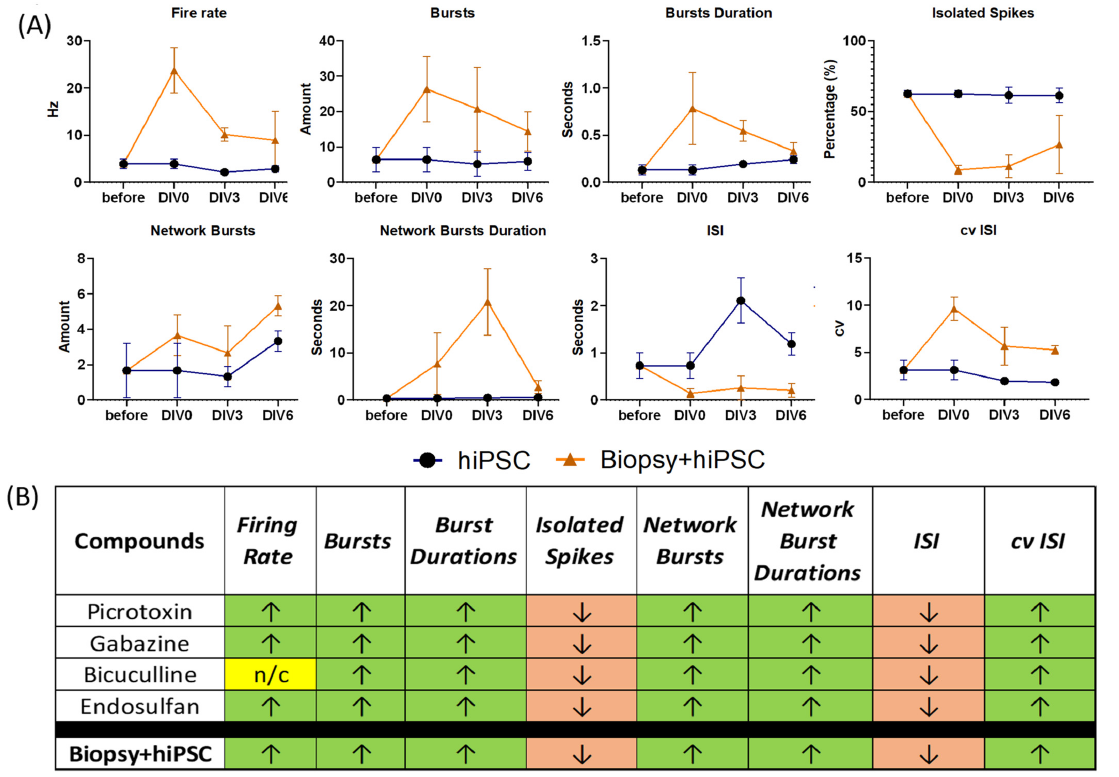
Figure 5. Electrophysiological characterization. ( A ) Fire rate, bursts and burst durations, isolated spikes, network bursts and durations, as well as ISI and cv of ISI of the hybrid model (hiPSC + Biopsy, orange), with hiPSC neuronal derived cultures (DIV16 = DIVO on graph) measured before and after biopsy assembly for 6 days and compared with the control hiPSC neuronal-derived cul- tures (DIV16) (hiPSC, blue) during the same 6-day period. Error bars represent mean with SEM of three 2 min recordings per condition. ( B ) The hybrid model displayed a higher firing rate, number of bursts, longer burst durations, network burst and durations, and a higher CV of ISI than the biopsy or neuronal monolayer alone. The hybrid model was also characterized by a decreased per- centage of isolated spikes and a reduced inter-spike interval. Taken together, the electrophysiolog- ical output signature of the hybrid model corresponds to the seizurogenic profile of hiPSC cultures treated with picrotoxin, gabazine, bicuculline, or endosulfan, as reported by Bradley et al. (2018) [30].; “n/c” = no change. Adapted with permission from [30]. Copyright 2018, Oxford University Press. To gain insight into the reproducibility of the model, a biopsy from another epilepsy pa- tient was submitted to the same procedures. In this second case, the recorded electrical activity was similar to that of the first case, with the exception of ISI, which showed an inconsistent and less pronounced increase over days in culture (Supplementary Figure S2). 4. Discussion This study describes the assembly of a hybrid brain model, combining a neocortical biopsy from a patient with epilepsy with a layer of hiPSC-derived cortical neurons cul- tured on a MEA. This setup allowed recordings of spontaneous electrophysiological ac- tivity for 6 days, with the main advantage being the possibility to study patient-derived biopsy postoperatively with commercially available consumables and a standardized readout system. During the first week of co-culturing of the hybrid model, we confirmed